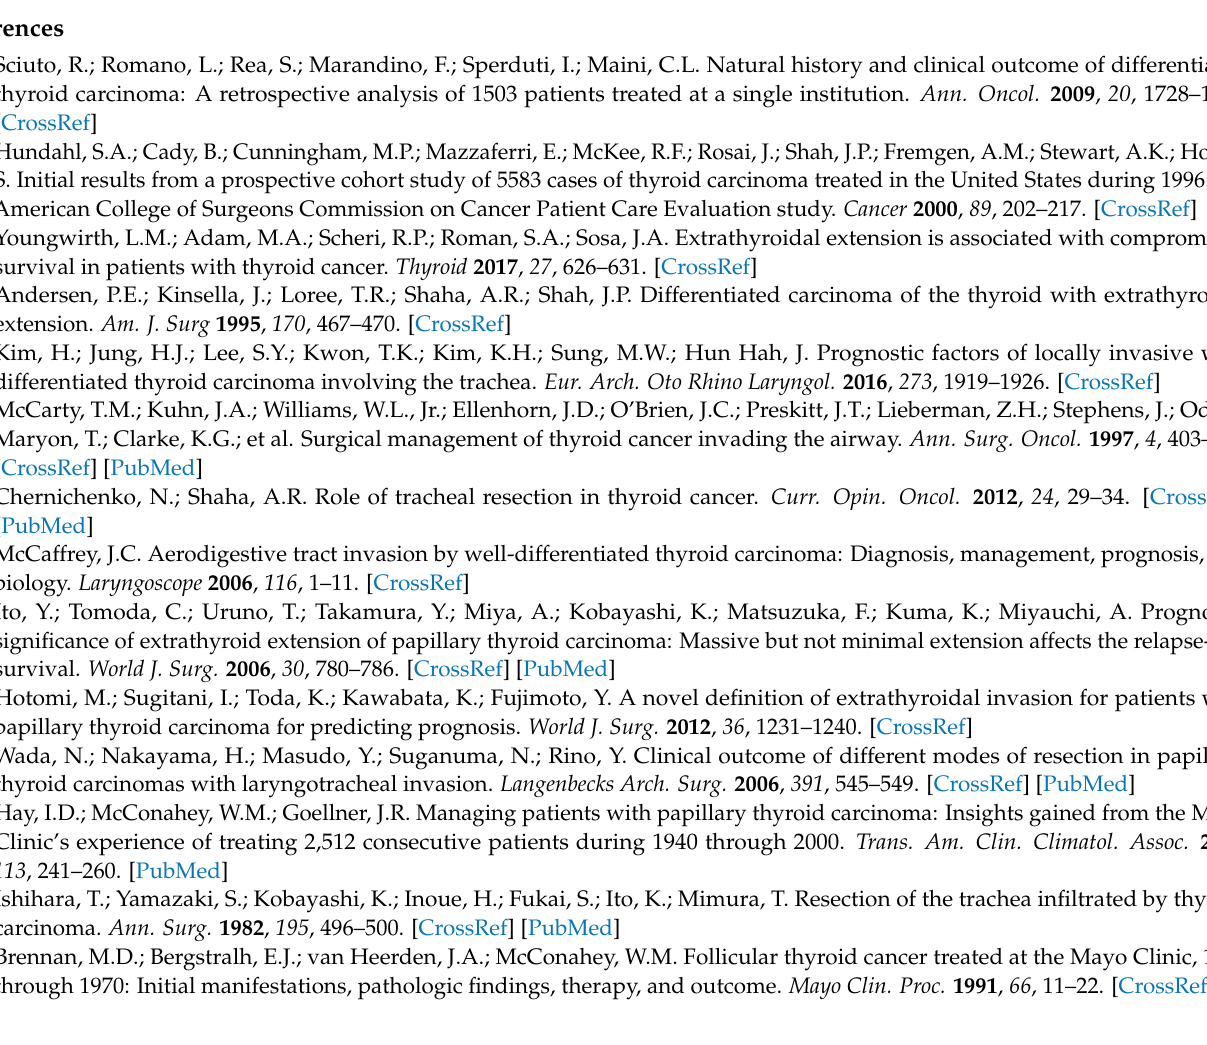
Figure 1. A schema depicting the surgical strategy for tracheal invasion of well-differentiated thy- roid cancer according to the extent of invasion.